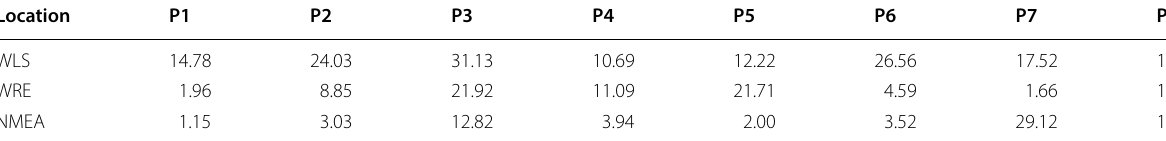
Table 6 The standard deviation of different positioning approaches (m) Location